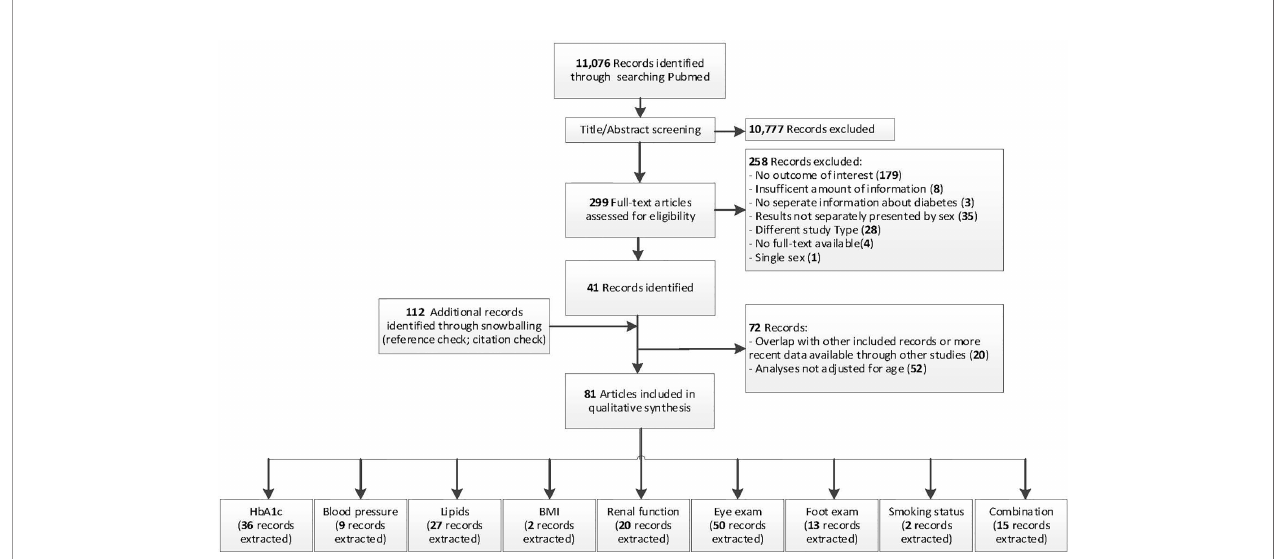
FIGURE 1 | Flowchart of study selection. PubMed search was used to obtain a suitable start set for